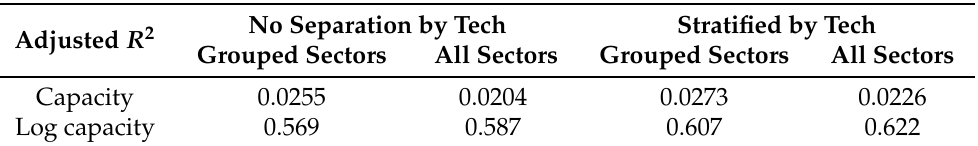
Table 1. Adjusted R 2 , a measure of goodness of fit for eight different linear regression models between (log) capacity, grouped or ungrouped sectors, and technology. A far better fit is observed for the exponential